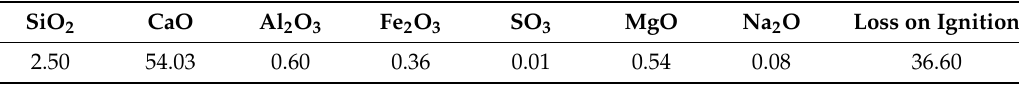
Table 4. Chemical compositions of crushed limestone (wt.%).